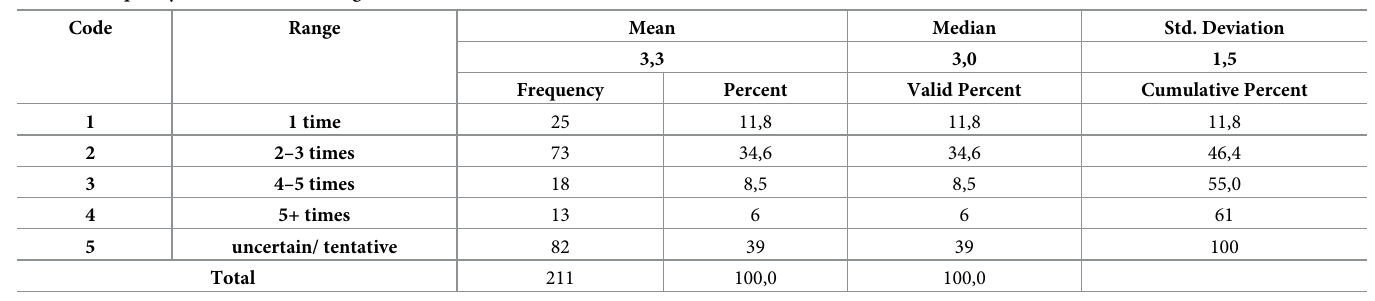
Table 5. Frequency of webinars attending.